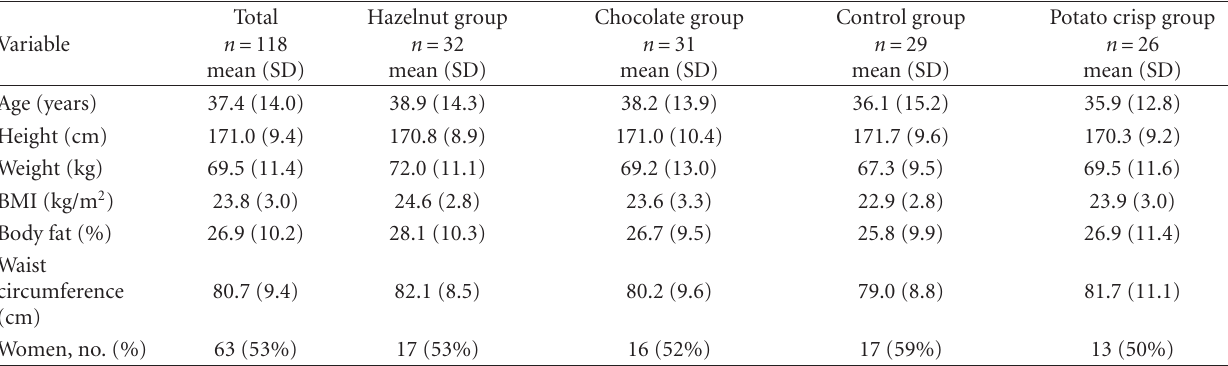
Table 1: Subjects’ characteristics for the total, hazelnut group, chocolate group, control group, and potato crisp group at baseline.